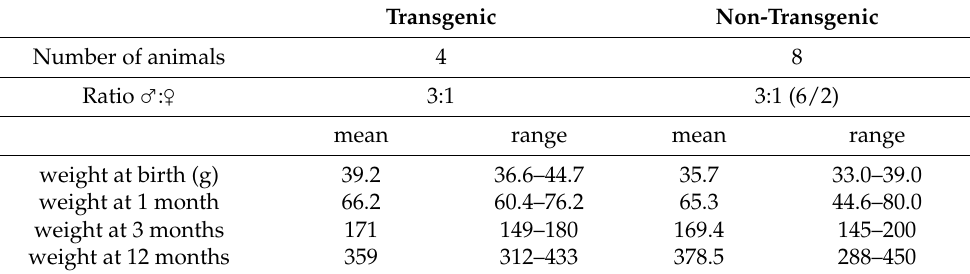
Table 2. Postnatal gain of weight of marmosets after embryo transfer. Transgenic